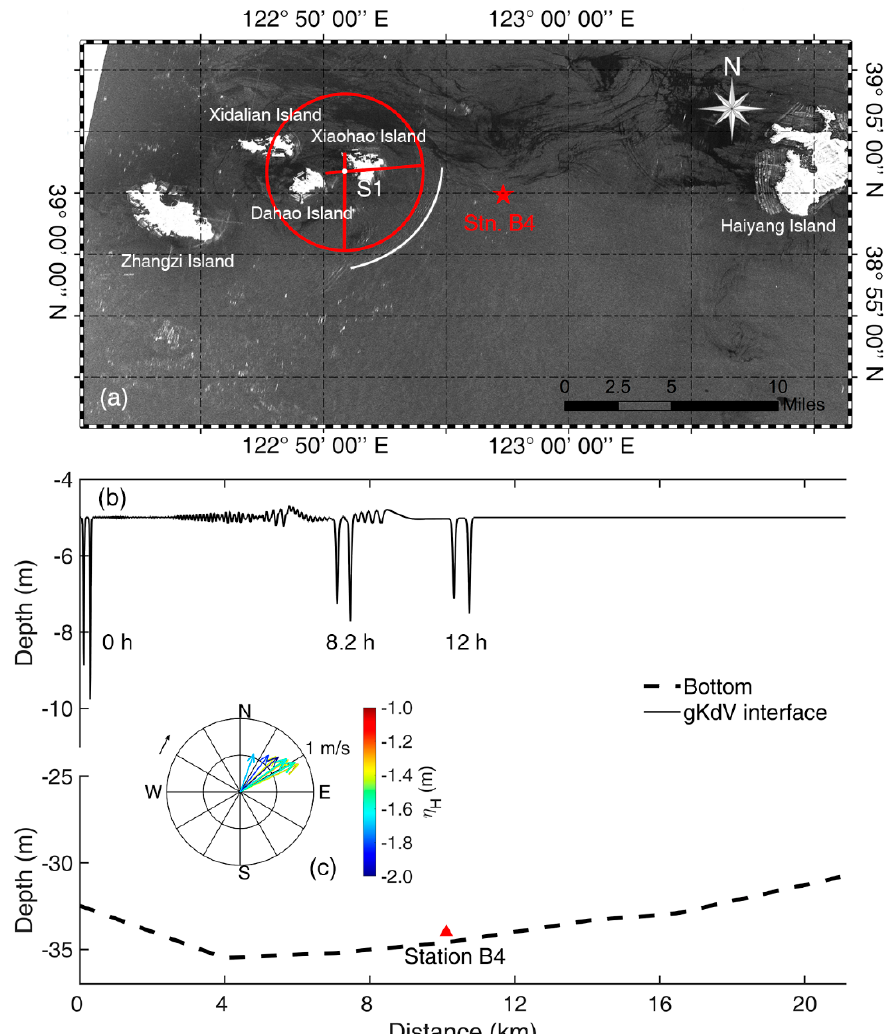
Figure 11. ( a ) SAR image was taken on 11 July 2019 (05:51 UTC + 8). The red circle indicates the estimated generation site (S1) traced by the ray-tracing method. The red star denotes location of Stn. B4. ( b ) The propagation process of ISWs simulated by the gKdV model. The dashed line indicates the topography. ( c ) The corresponding tidal current at S1 at the moment of ISW generation. Colors represent the surface elevation, and the arrow indicates the direction of tidal variations.